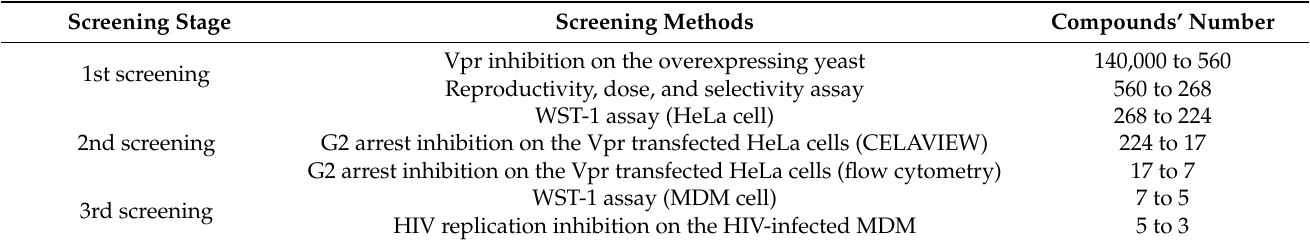
Figure 1. The first screening of the HIV-1 Vpr inhibitor using yeast-based high-throughput screening. ( a ) The growth defect of fission yeast strains with the HIV Vpr overexpression. The fission yeast cells harboring the Vpr-wild type (portion 1) or Vpr mutant R80A (portion 2), or the empty control (portion 3), were streaked on an MM medium for overexpression (upper plate) and an SD medium for repression (lower plate), and they were incubated at 30 ◦ C for 3 days. ( b ) Twenty µ M of 140,000 candidate compounds was added to the Vpr-expressing yeast cultured in an MM medium and cultured for 20 h. Yeast cell growth was assessed by WST-1 assay, and the proliferation recovery rate was calculated. The red line represents the hit criteria of the proliferation recovery rate of 15%, which was set as the threshold by over three-fold the standard deviation of all compounds. Table 1. Screening methods for the new therapeutic drug, targeting HIV Vpr (Tables S1–S3).